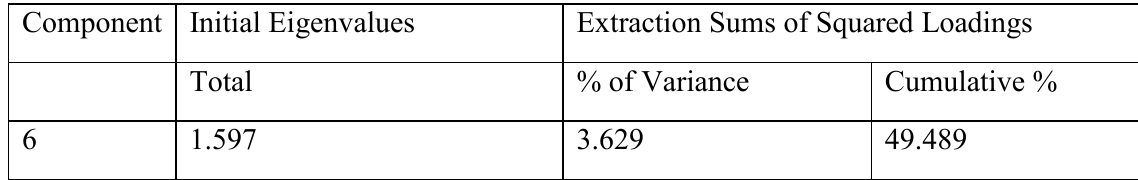
Table 1.11: Variance explained for Absorptive Resilience PC6 Component